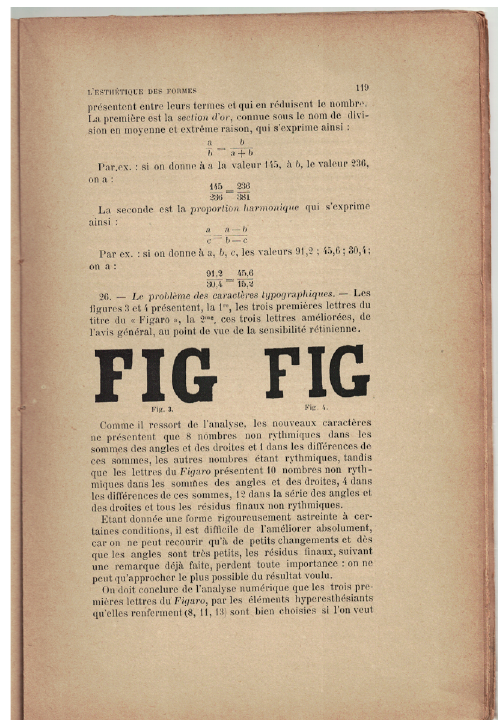
Fig. 7 Charles Henry, ‘L’Esthétique des formes’, La Revue blanche , 8.40 (1 February 1895), p.